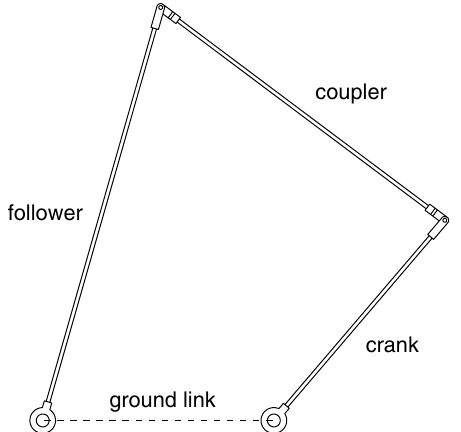
Figure 2. Four-bar linkage mechanism.